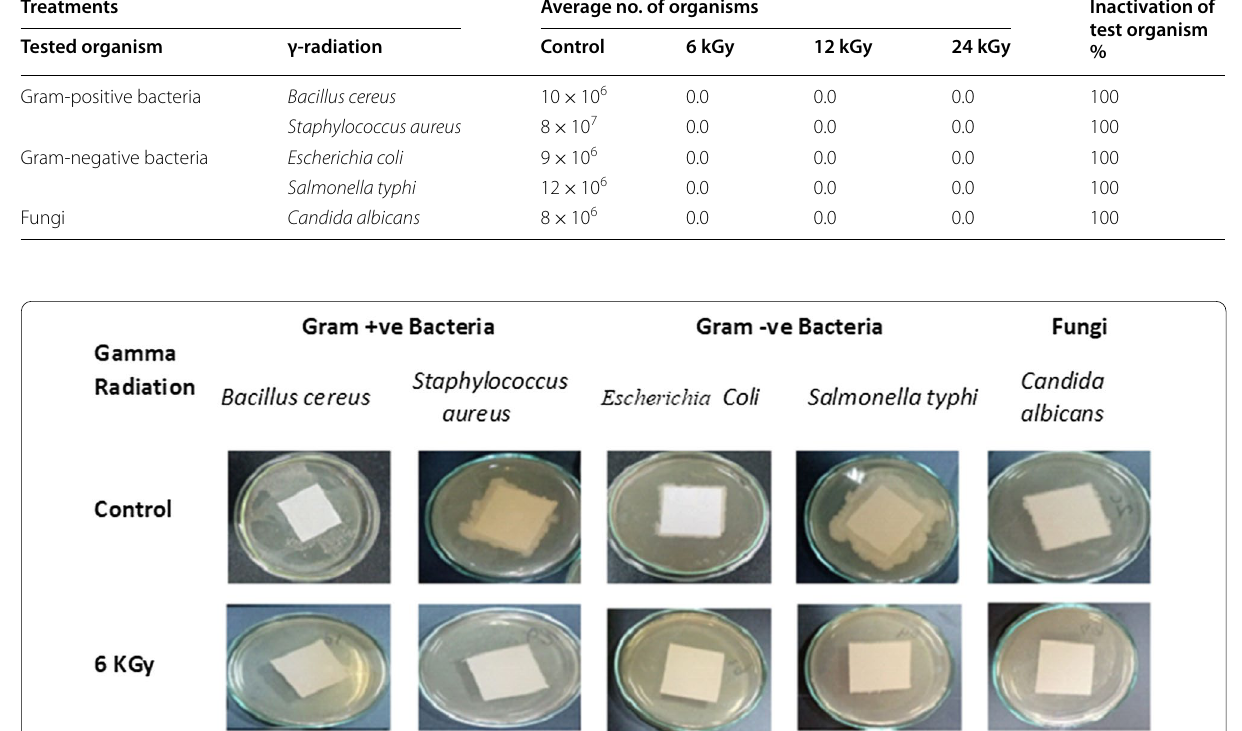
Table 1 The efficiency of gamma radiation in the sterilization of pathogenic contaminated paper Treatments Average no. of organisms